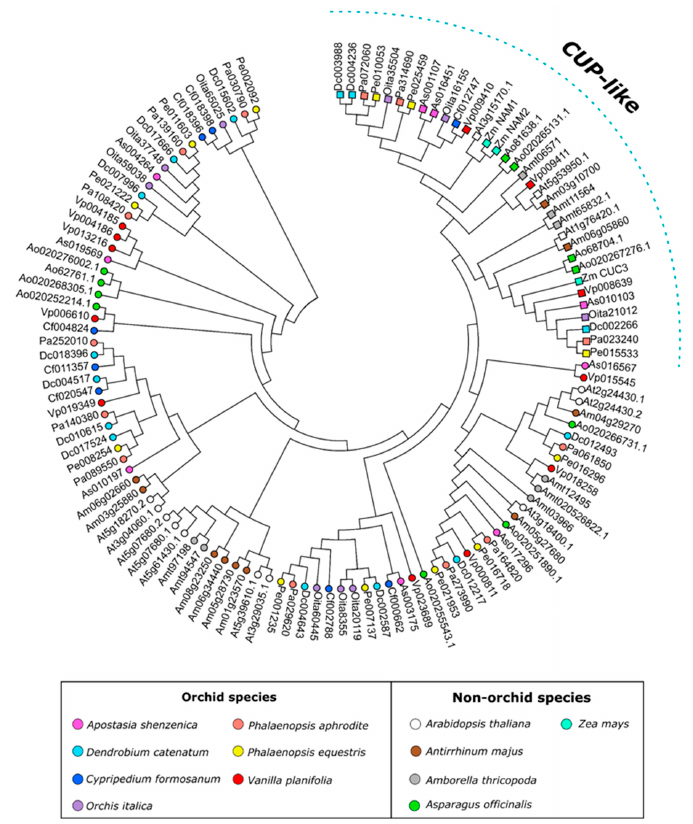
Figure 2. ML tree of the NAM subfamily. The sequences of the CUP and CUP-like proteins are marked with colored squares. The tree includes sequences from all the orchid and non-orchid species examined in this work.